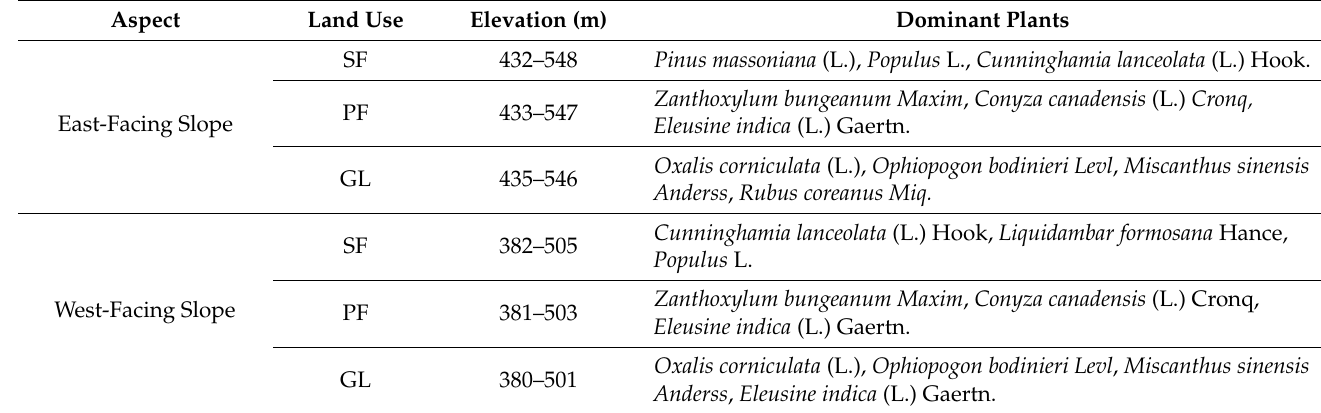
Table 1. Basic information of the sampling